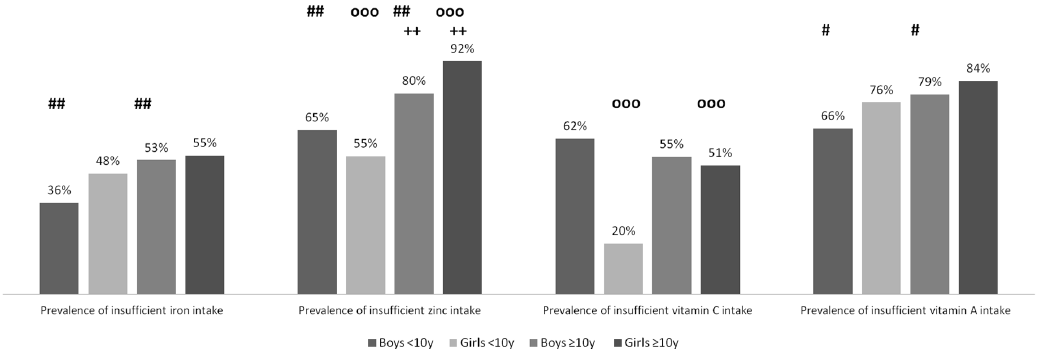
Figure 2. Prevalence of insufficient micronutrient intake according to age and gender group; p ‐ value for χ 2 ‐ test between boys ≥ 10 years and girls ≥ 10 years; ++: p ‐ value < 0.01; p ‐ value for χ 2 ‐ test between boys <10 years and boys ≥ 10 years; ##: p ‐ value < 0.01; # p ‐ value <0.05; p ‐ value for χ 2 ‐ test between girls <10 years and girls ≥ 10 years: ooo: p ‐ value < 0.001.